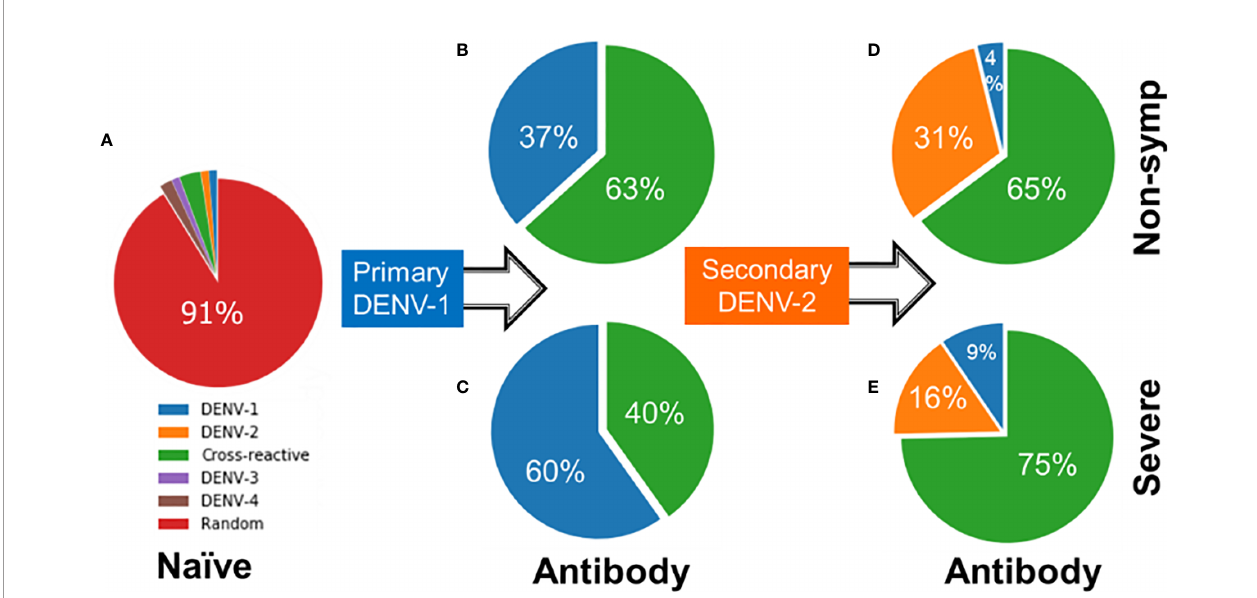
FIGURE 6 | Starting from (A) naïve B cells, pro fi le of antibodies generated during (B, C) primary infections by DENV-1 and (D, E) secondary infections by DENV-2 showing percentages of speci fi c, cross-reactive or antibodies of no binding af fi nity to any dengue serotype (random) for both severe and non-symptomatic cases.